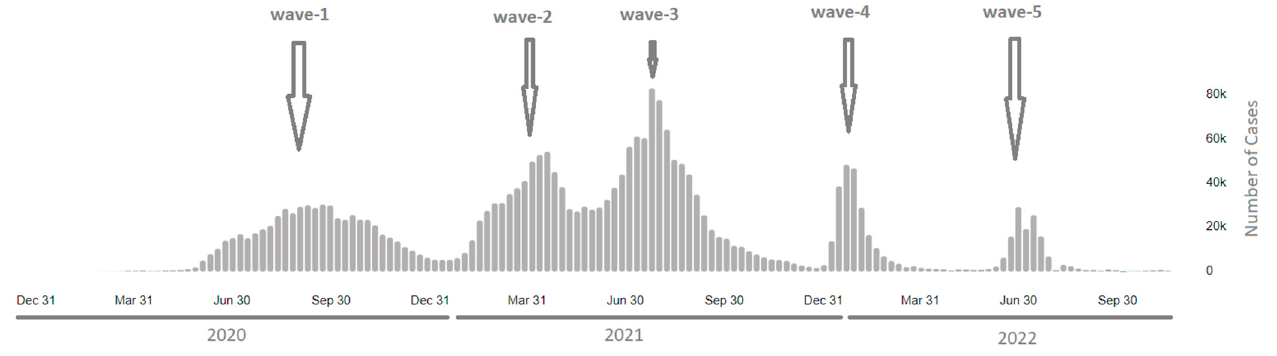
Figure 8. Daily cases and waves of SARS-CoV-2 in Iraq published on the WHO Coronavirus dashboard.